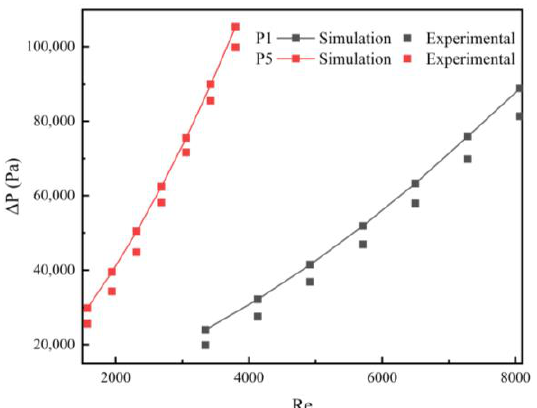
Figure 8. Pressure drop of the long micro-tube with dimples for different Reynolds numbers and Prandtl numbers conditions.